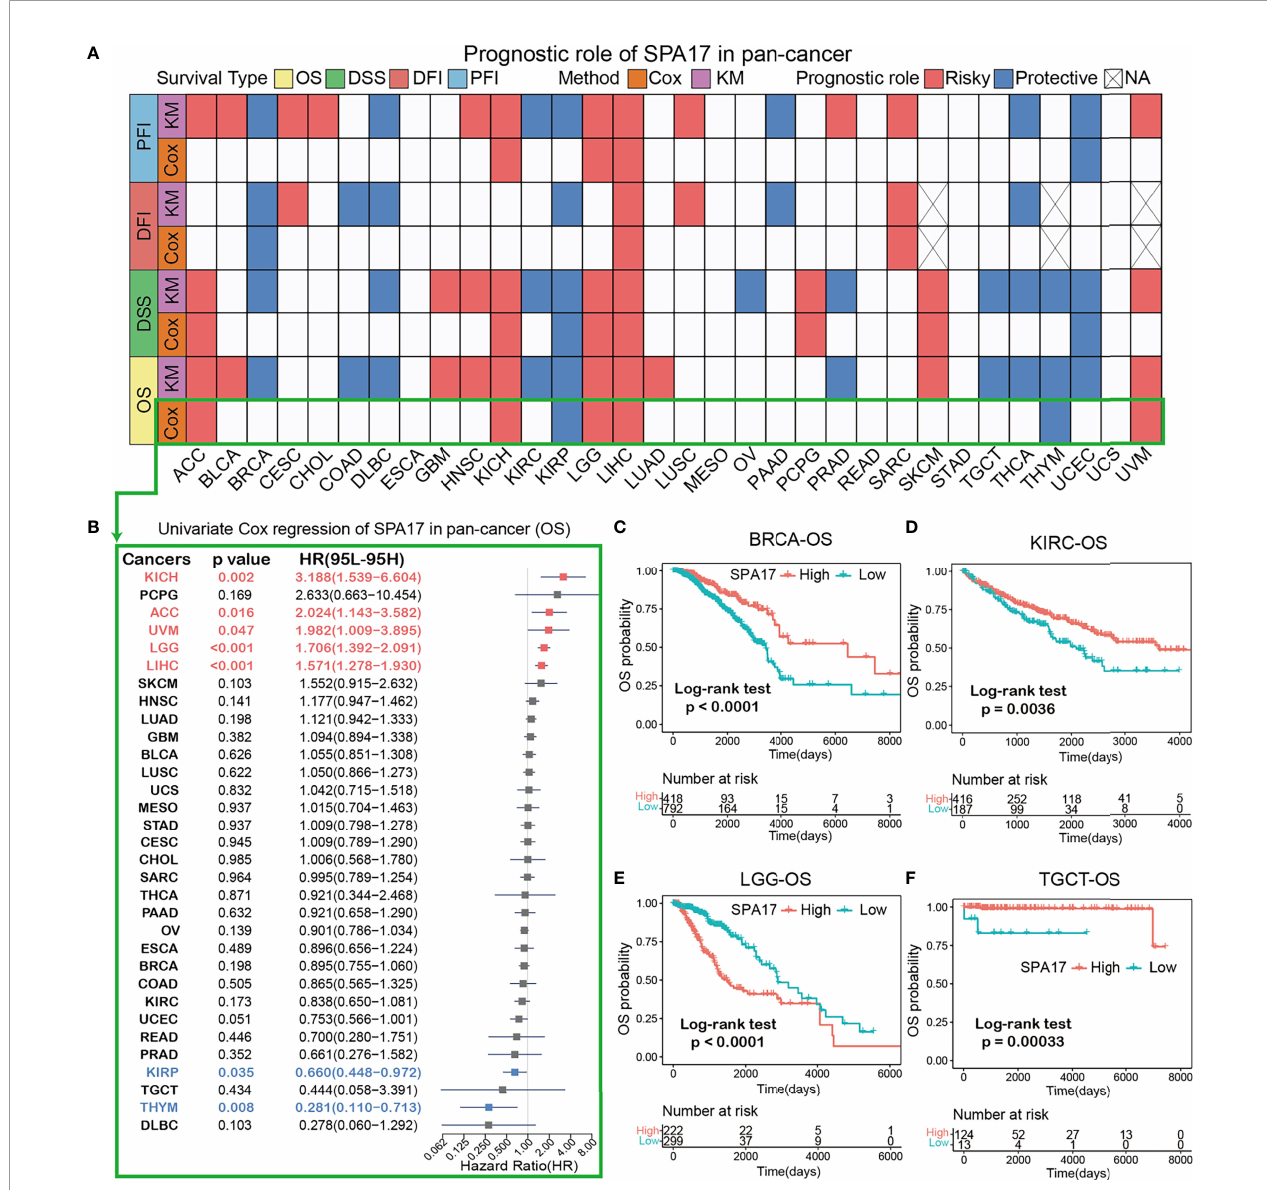
FIGURE 2 | (A) Based on the univariate Cox regression and Kaplan-Meier models, summary of the correlation between SPA17 expression and overall survival (OS), disease-speci fi c survival (DSS), disease-free interval (DFI) and progression-free interval (PFI). Red indicates that SPA17 is a risk factor for the prognosis of cancer patients, while blue represents a protective factor. Only p-values < 0.05 are shown. (B) The forest plot showed the prognostic role of SPA17 in cancers by univariate Cox regression. The red type of cancer represents SPA17 as a statistically signi fi cant risk factor, and blue represents a protective factor. (C – F) Kaplan-Meier overall survival curves of SPA17 in BRCA (C) , KIRC (D) , LGG (E) and TGCT (F)